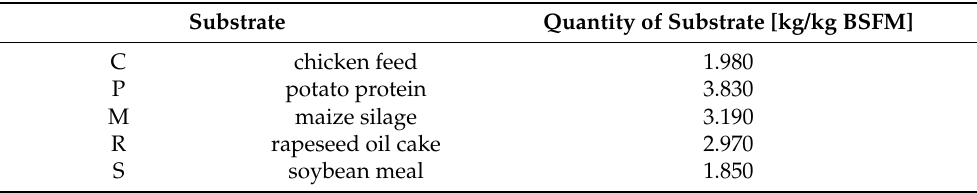
Table 1. Approximate quantity of substrate required for the production of 1 kg BSF (wet weight).